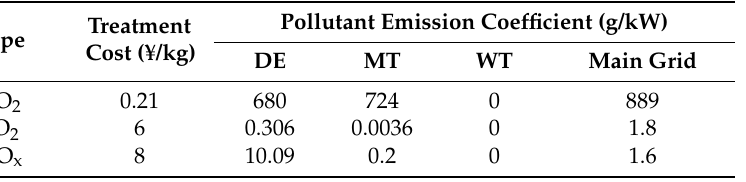
Table 1. Data of capacity limits. Table 3. Environmental parameters.